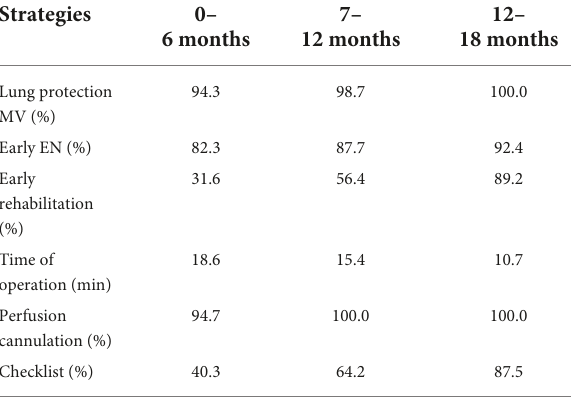
TABLE 2 Compliance of the strategies during post-implementation periods.